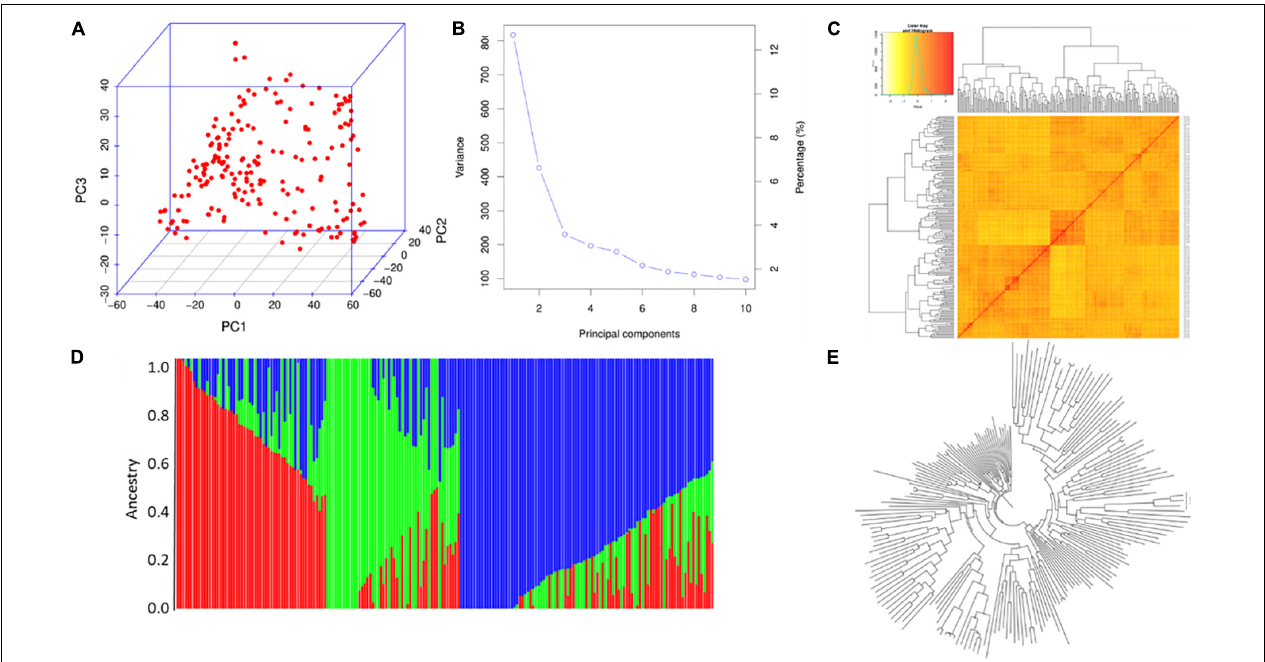
FIGURE 5 | Population analysis for the AUS panel. (A) Principal component analysis (PCA) plots. (B) Total variation explained by the principal components (PCs). (C) Kinship relatedness. (D) Three subgroups inferred by structure analysis. (E) Neighbor-joining (NJ)